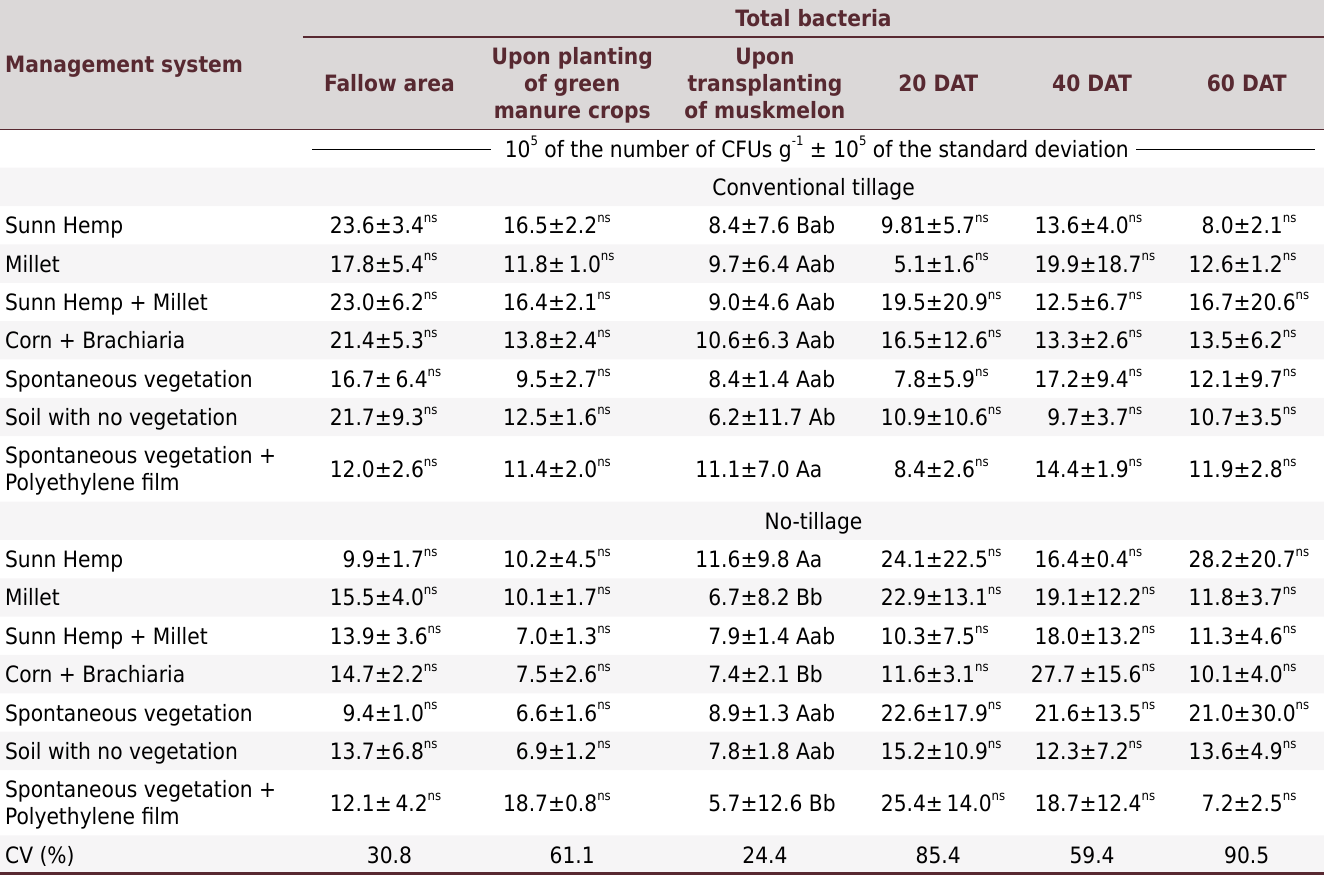
Table 1. Number of colony forming units (CFUs) of total bacteria throughout the muskmelon cycle in different management systems and soil sampling times.